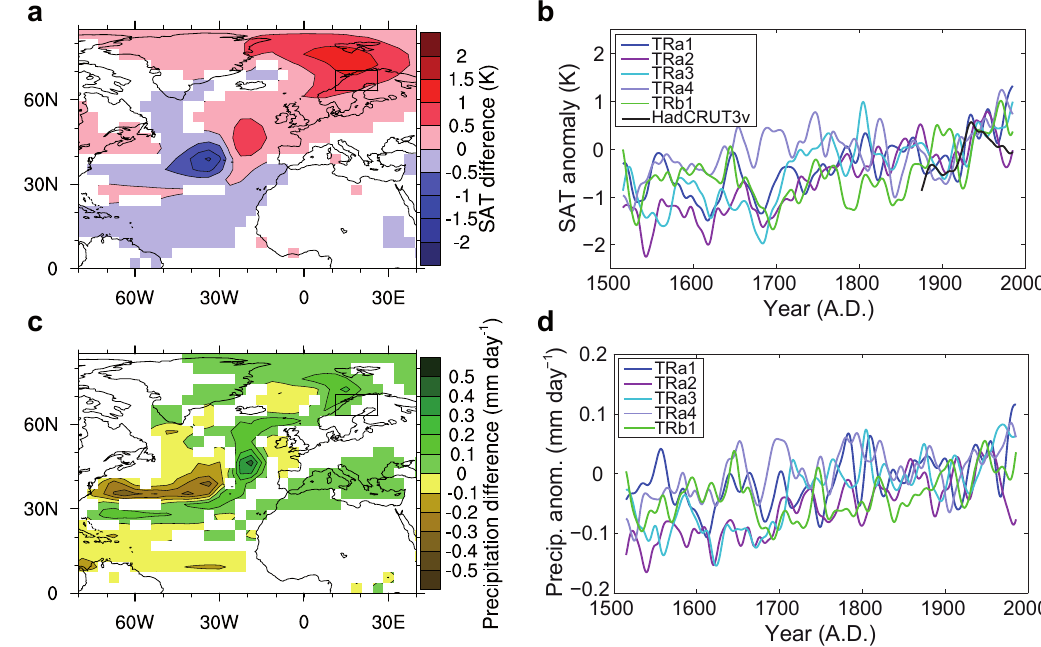
Fig. 9. The atmospheric response due to the changed ocean circulation in Type 3 transitions: (a) SAT difference pattern of the weak versus the strong AMOC state after the linear effect of the forcing has been removed (first method). Only the values that are statistically significant at the 5% level based on the two-sided Student’s t-test are colored. (b) low-pass filtered time series of the SAT averaged over the black box (63 ◦ N–70 ◦ N, 11 ◦ E–26 ◦ E) in figure (a) for all transient simulations. Additionally, the mean temperature for Northern Scandinavia according to the HadCRUT3v data is shown. The time series show anomalies with respect to the mean of the period 1900–1950 A.D. (c) and (d) as (a) and (b) for